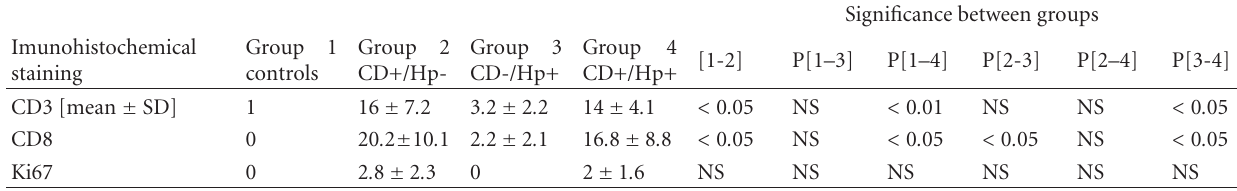
Significance between